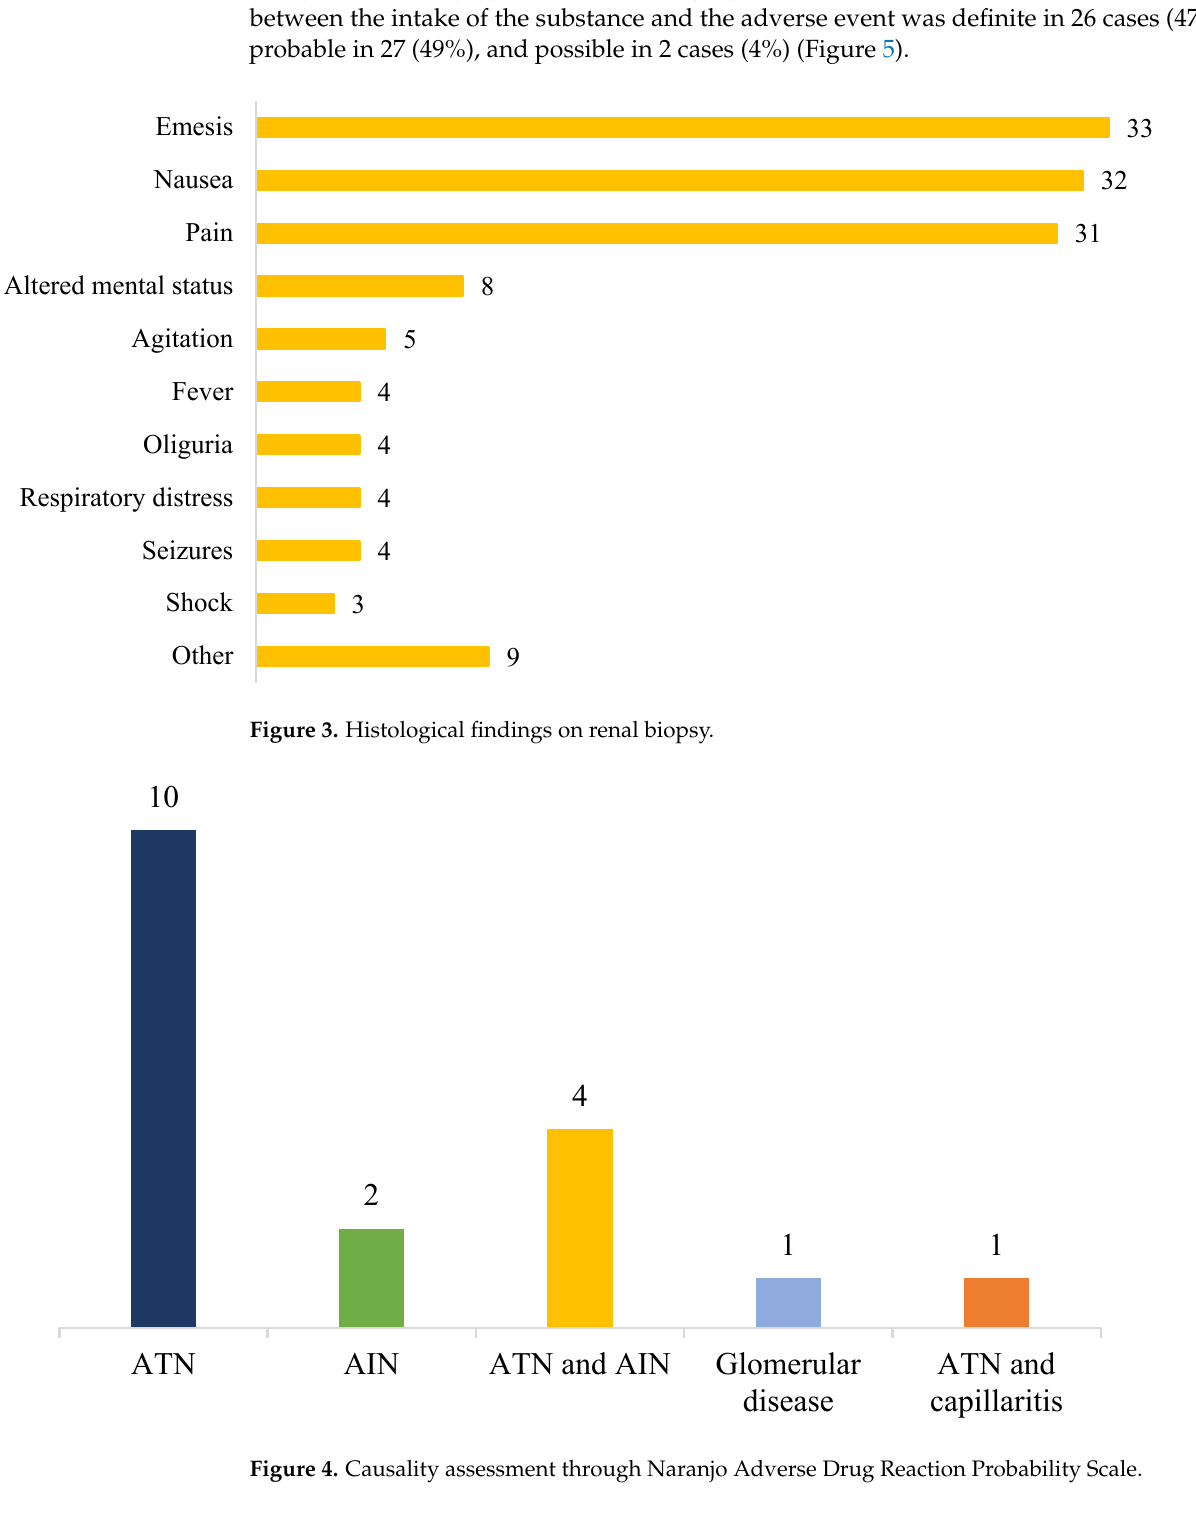
5 of 15 Figure 2. Age distribution of synthetic cannabinoid-induced acute kidney injury. The use of SCs was declared anamnestically in all cases; the co-intake of one or more